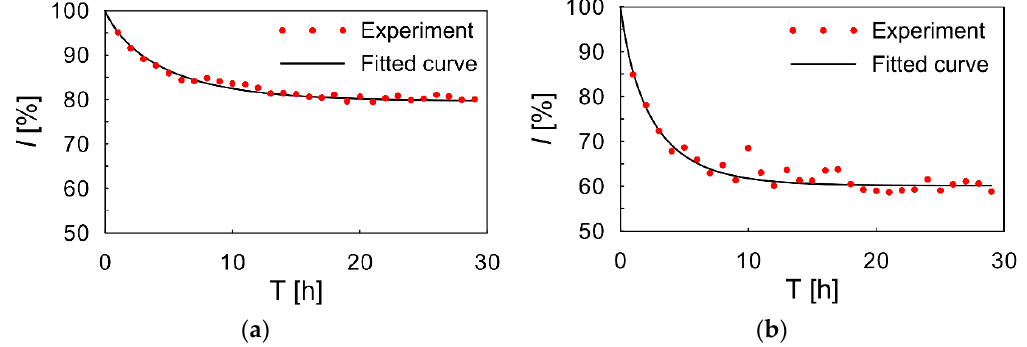
Figure 18. Relative damage severity: ( a ) 8 J scenario; ( b ) 5 J scenario.